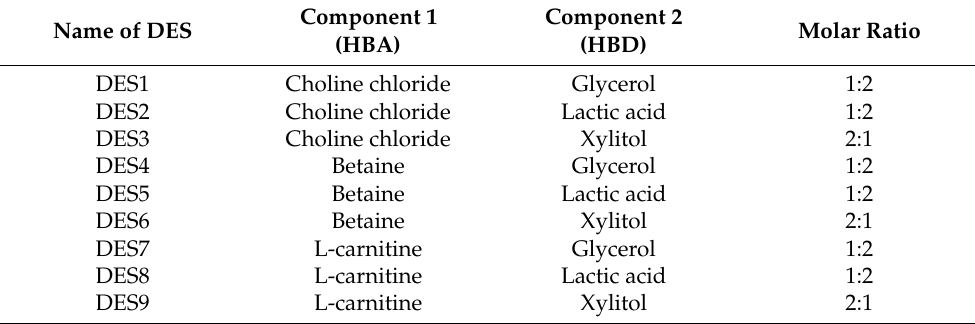
Table 1. The composition of nine kinds of deep eutectic